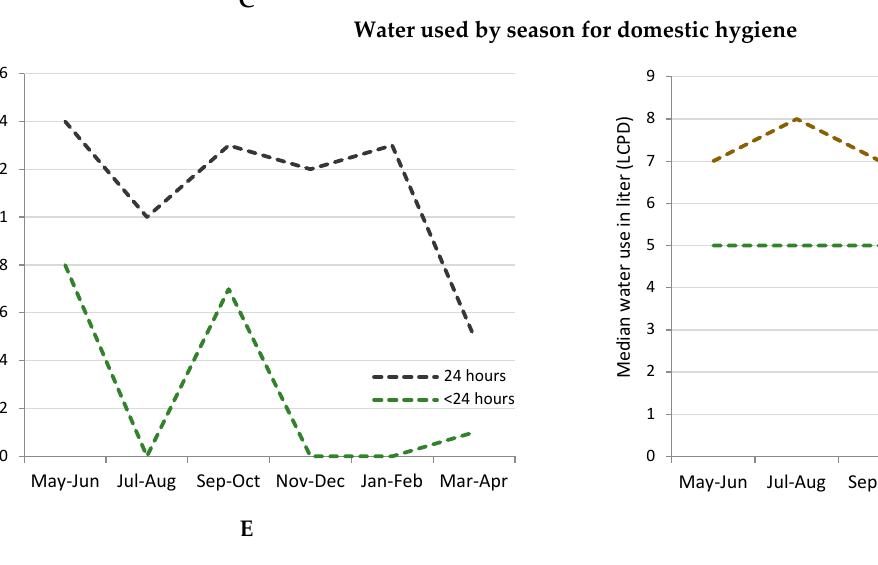
Figure 2. Quantity of water used, LCPD in different months of the year among low-income urban residents of Arichpur, Dhaka, from May 2015 to March 2016. ( A ). Total water used by months, ( B ). Bathing by months, ( C ). Handwashing by months, ( D ). Drinking by months, ( E ). Room(s) cleaning by months, ( F ). Dishwashing by months